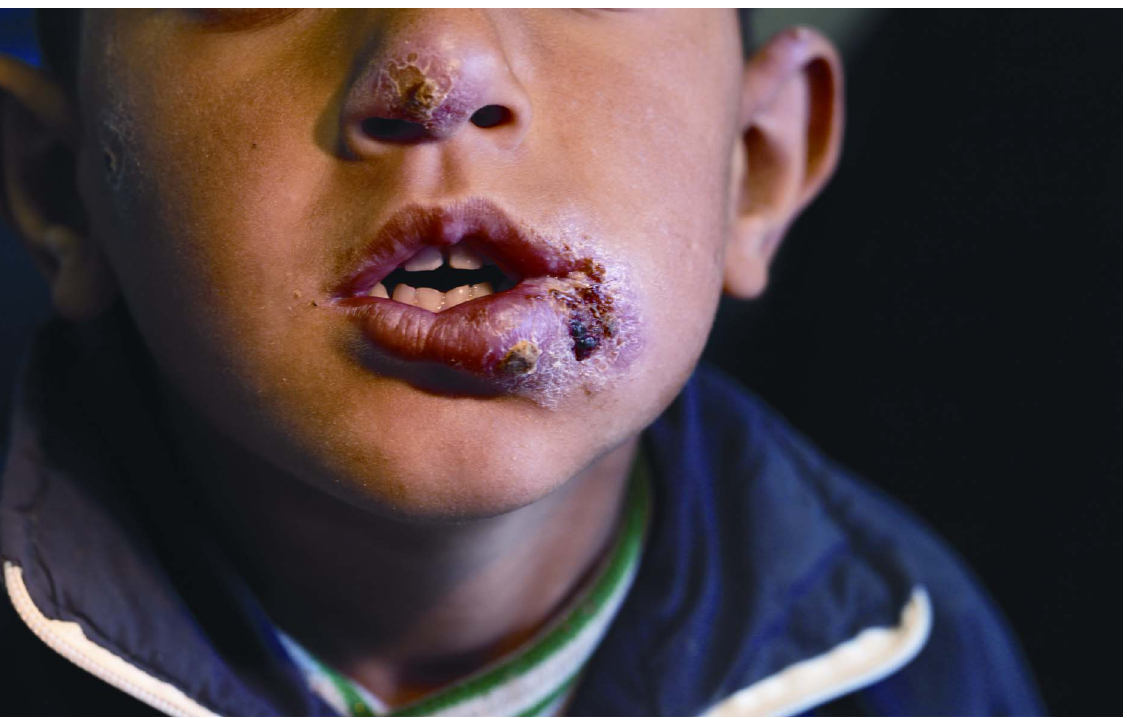
Figure 1. Syrian child from a Lebanon refugee camp, presenting multiple lesions from cutaneous leishmaniasis, courtesy of Dr. Ibrahim Khalifeh